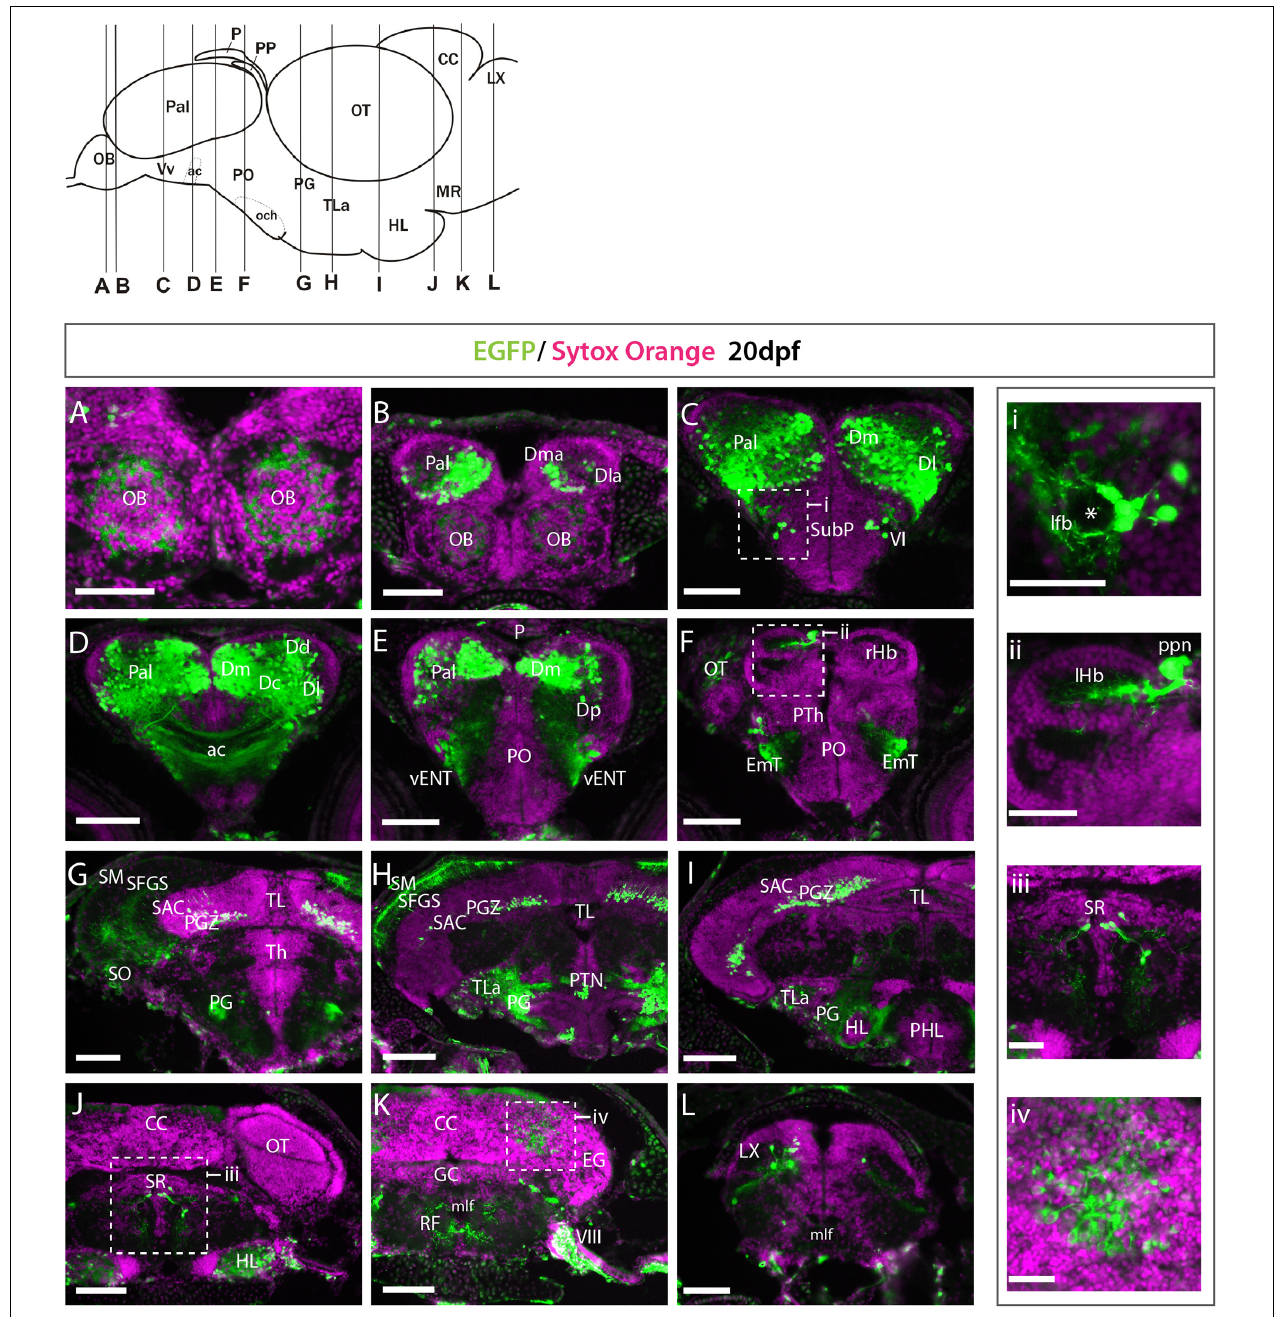
FIGURE 3 | Et (gata2:EGFP) bi105 expression at 20 dpf. (A–L) Transverse section through an Et( gata2 :EGFP) bi105 fish showing EGFP expression from rostral (A) to caudal areas (L). Schematic of lateral view of the brain (top left) shows levels of the sections. i-iv: detail of the areas marked in panels (C,F,J,K) . Areas of EGFP expression at this stage was consistent with those seen at 3dpf; the only de novo expression observed was in the cerebellum and vagal lobe (K,L,iv) . Asterisk labels the lateral forebrain bundle (lfb). Scale bars: (A–L) 100 µ m; (i–iv) 40 µ